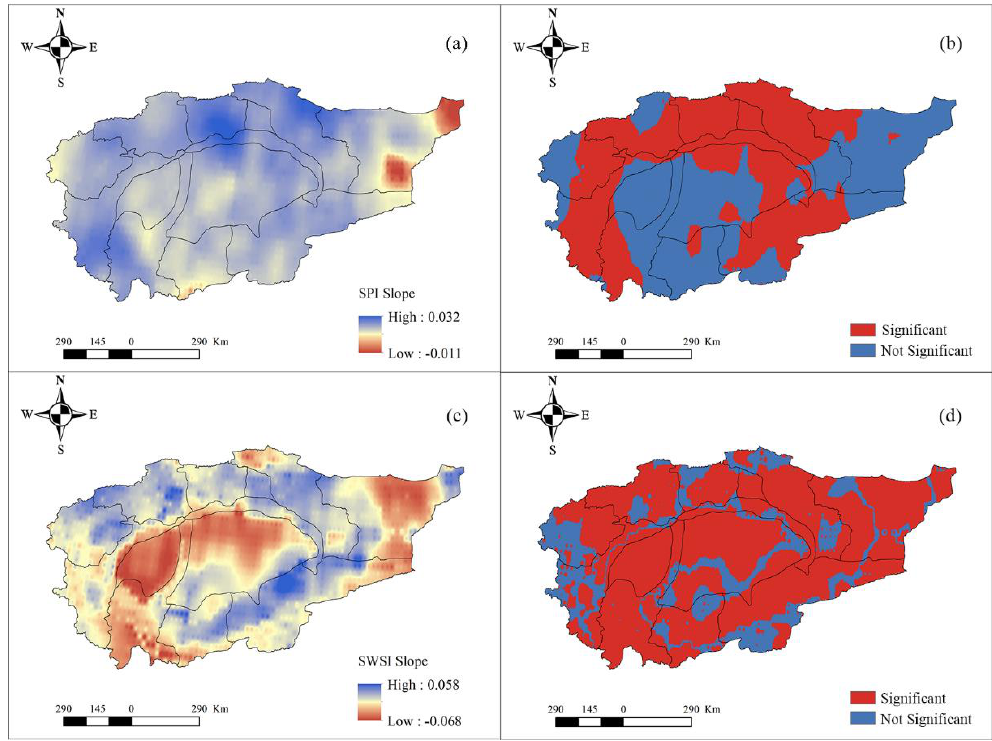
Figure 4. The spatial pattern of the SPI slope ( a ) and its significance ( b ) and SWSI slope ( c ) and its significance ( d ) during 1960 – 2014.